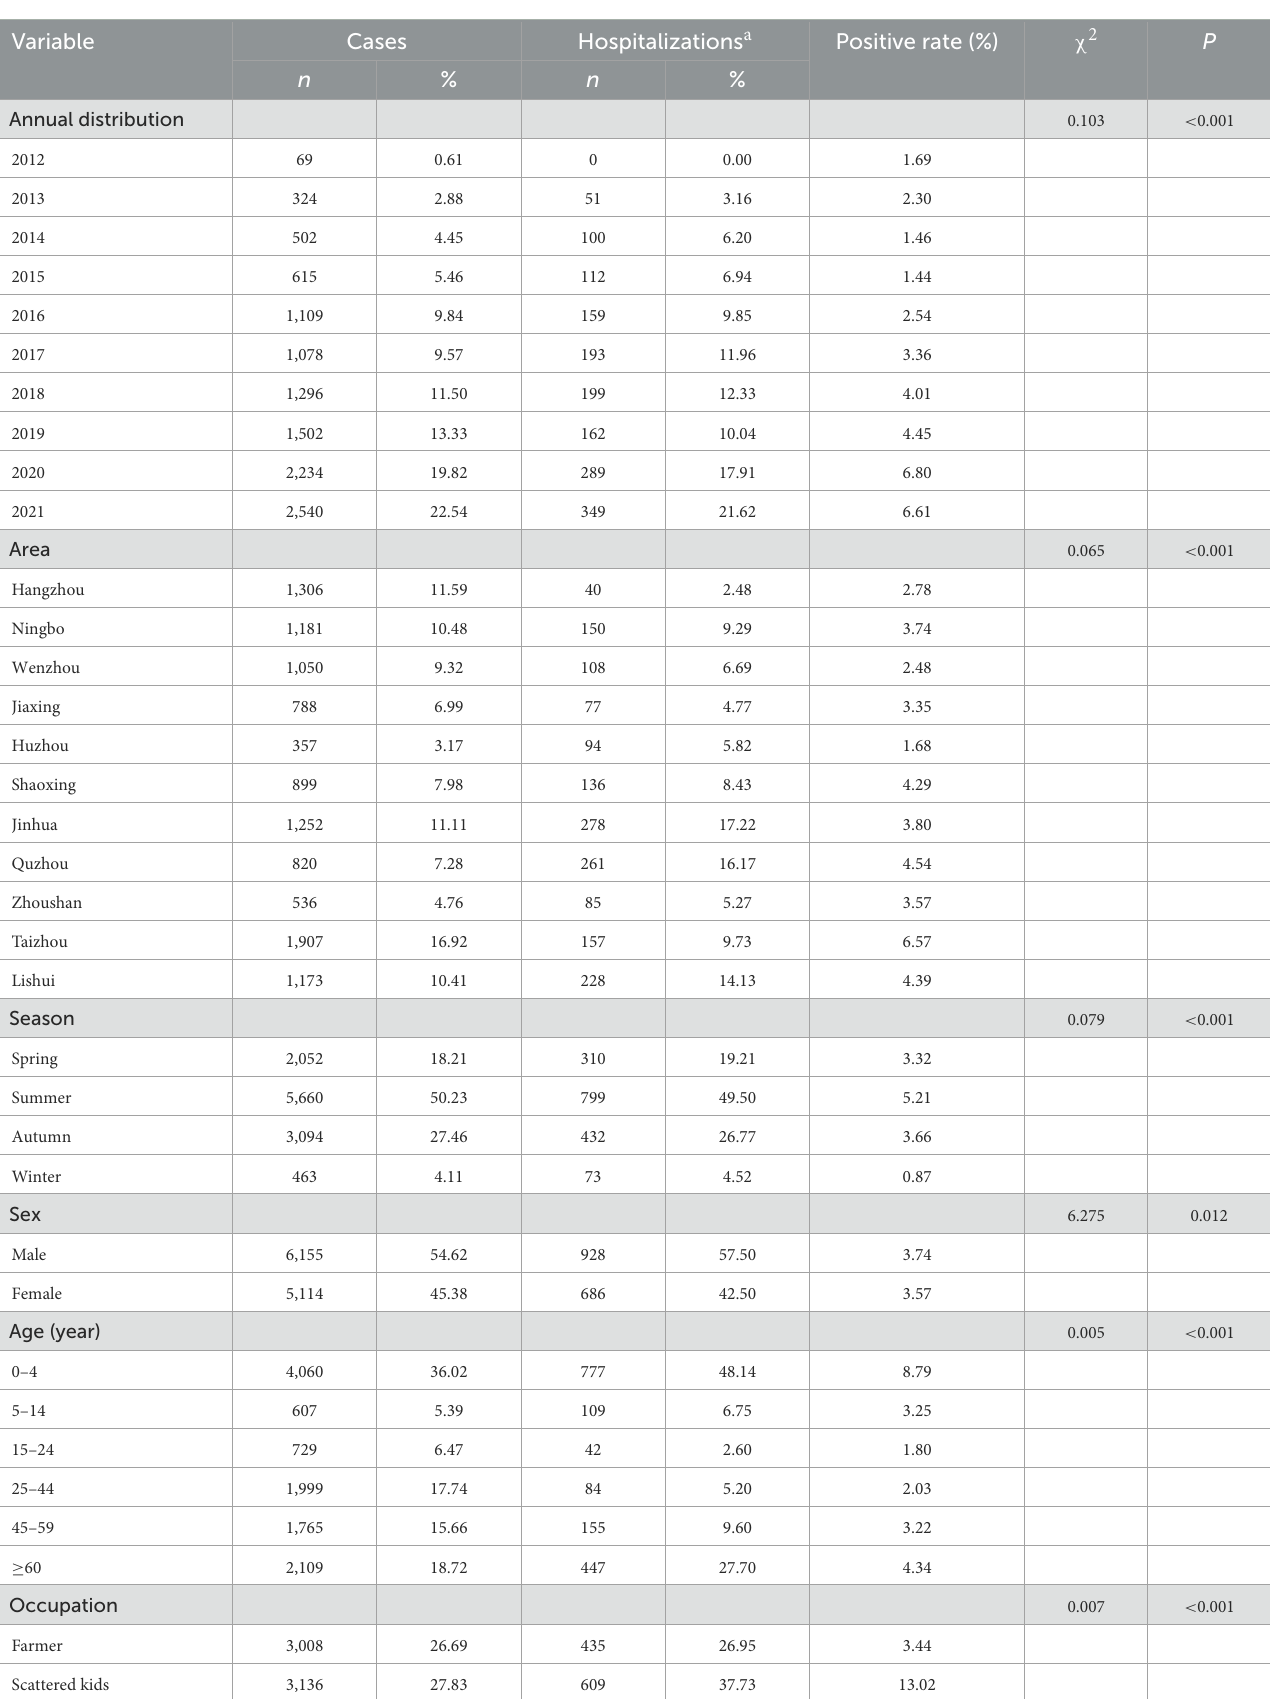
TABLE 1 Demographic characteristics and Salmonella positive rate in Zhejiang Province from 2012 to 2021.